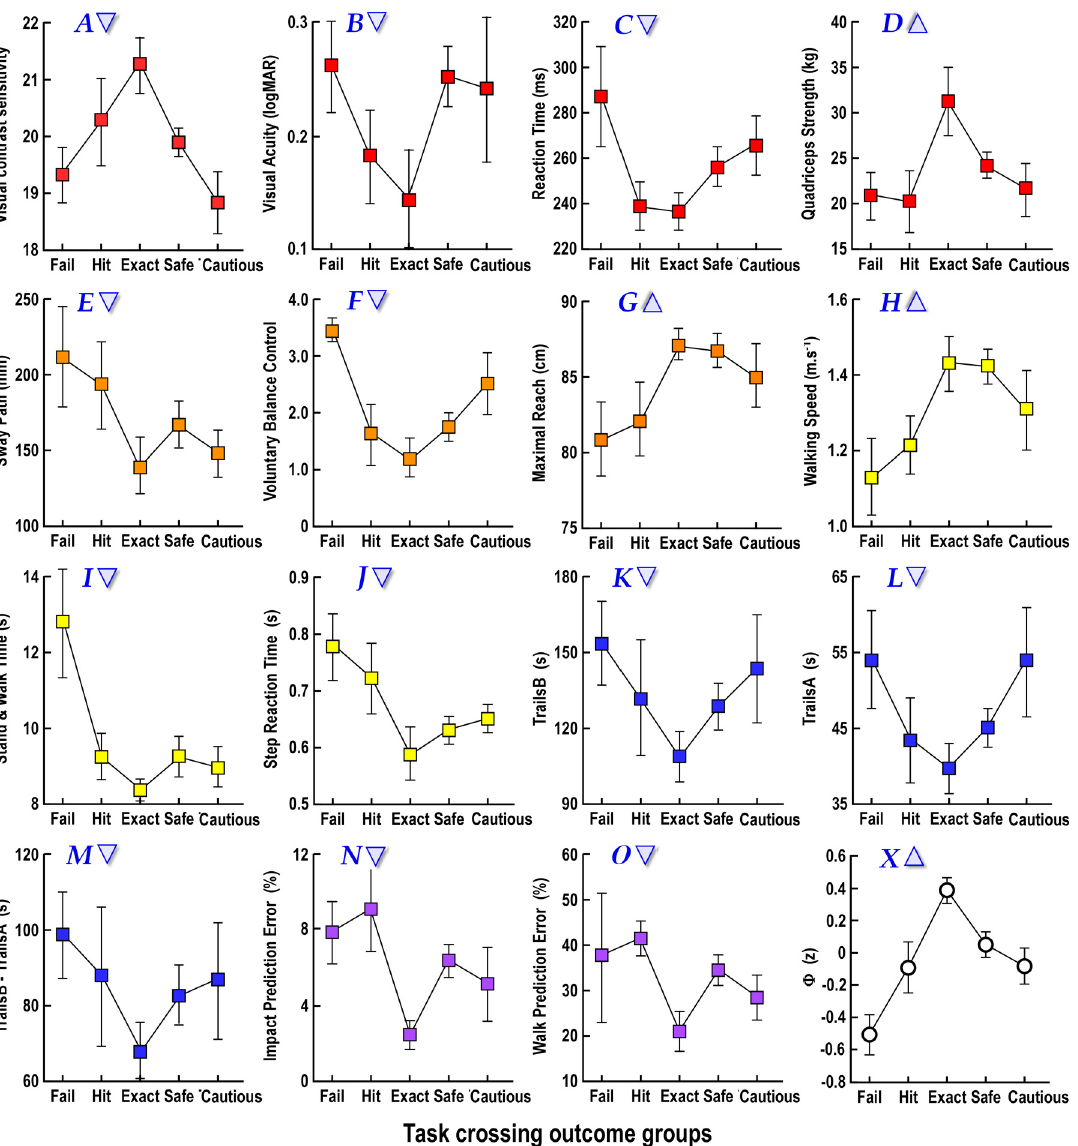
Fig 6. Physiological and cognitive associations with crossing behaviour in the task crossing. Mean performance ( ± SEM) in a range of physical and cognitive tests for the five groups classified according to road-crossing behaviour in the task crossing. For each graph, the triangle points in the direction of better performance. A , B , C,D . Tests of basic function ( visual contrast sensitivity , visual acuity , simple reaction time , strength ). E , F,G . Tests of standing balance control ( sway , voluntary balance control , maximal reach ). H , I,J . Tests of walking and stepping function ( walking speed , stand and walk time , choice stepping reaction time) . K,L,M. Cognitive tests of search and set shifting ( TrailsB , TrailsA , TrailsB — TrailsA ). N. Arrival prediction error of the moving object. O. Arrival prediction error of the imagined walk. X shows the overall function score as a z -score average across all